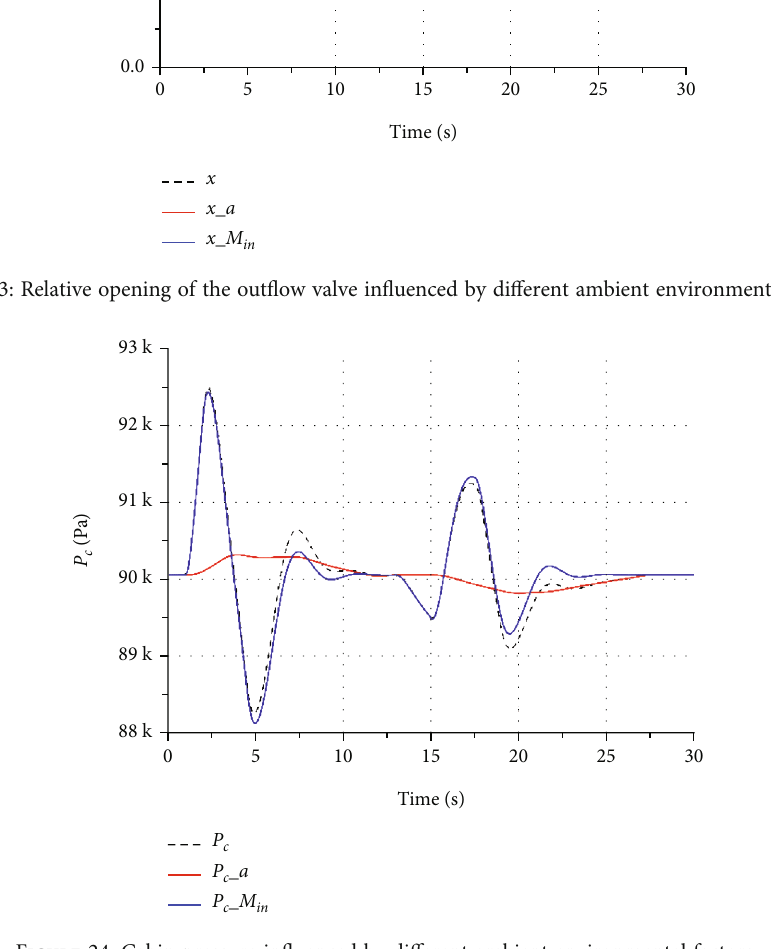
Figure 24: Cabin pressure in fl uenced by di ff erent ambient environmental